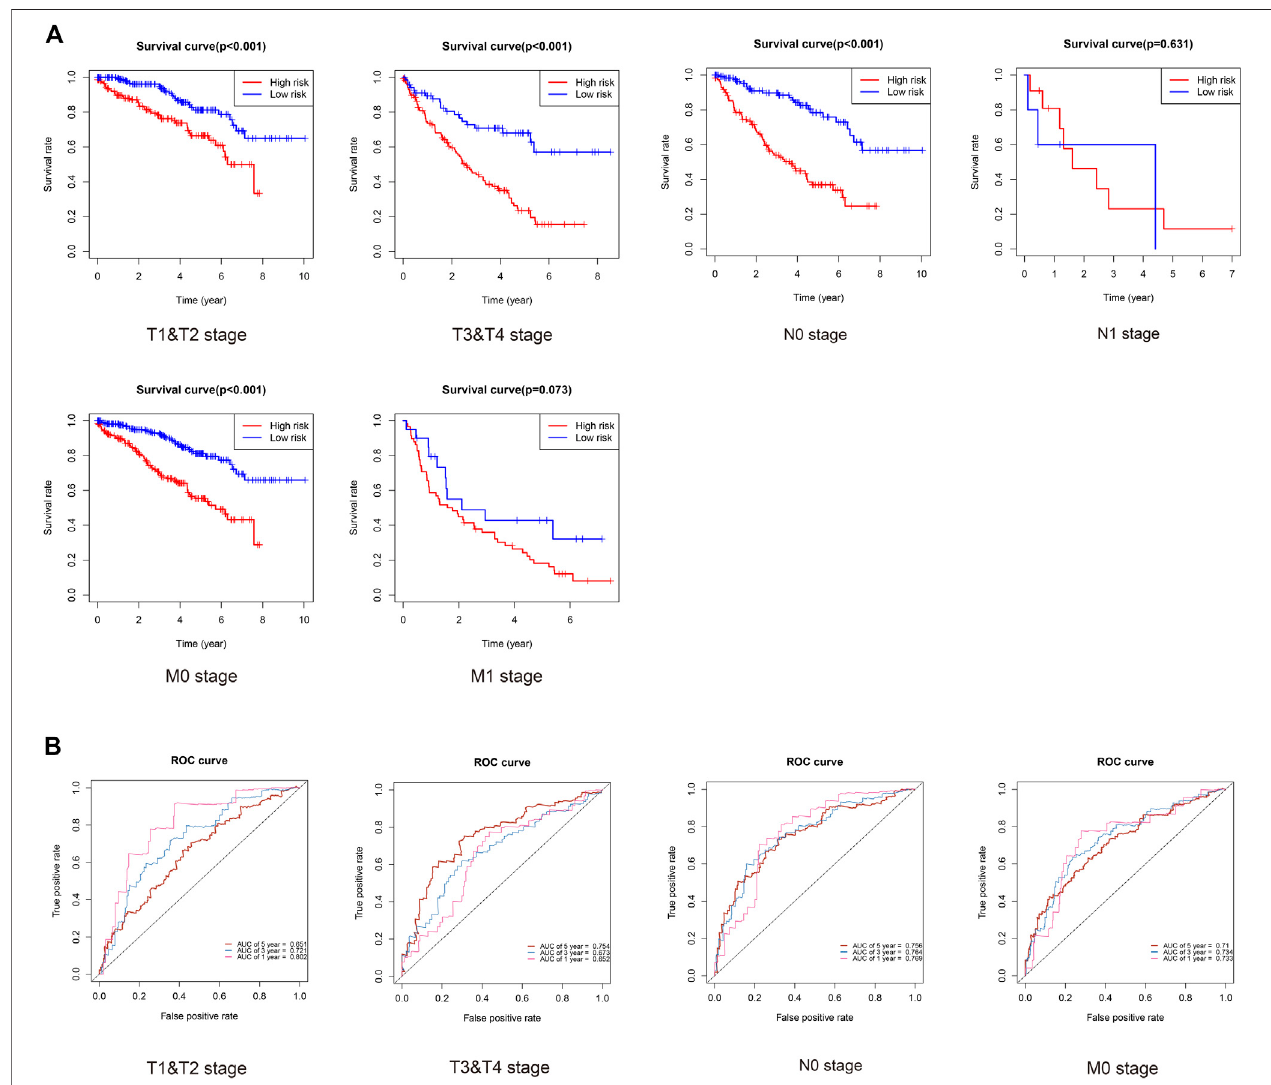
FIGURE 9 | Prognosis of KIRC patients under same clinicopathologic characteristics and ROC curves for 1-, 3-, and 5-year survival prediction.